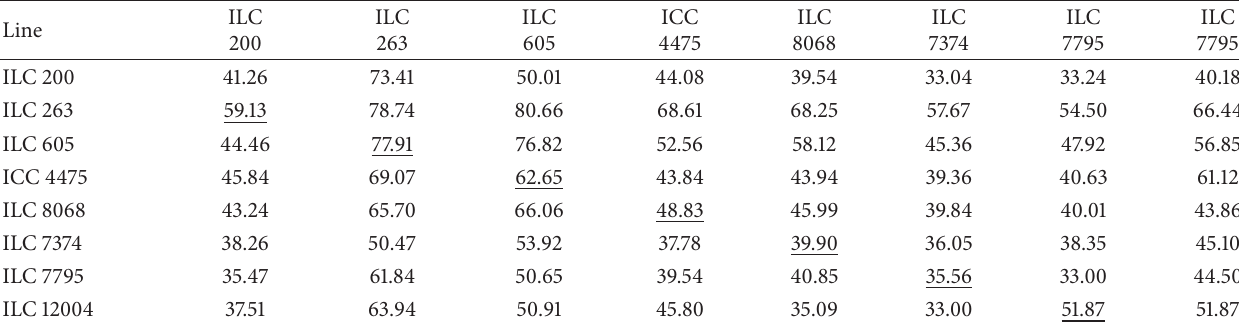
Table 2: Mean value of disease severity of chickpea inoculated by Ascochyta rabiei in a diallel cross at the seedling stage for the F1 generation above the underlined data and the F2 generation below the underlined data.